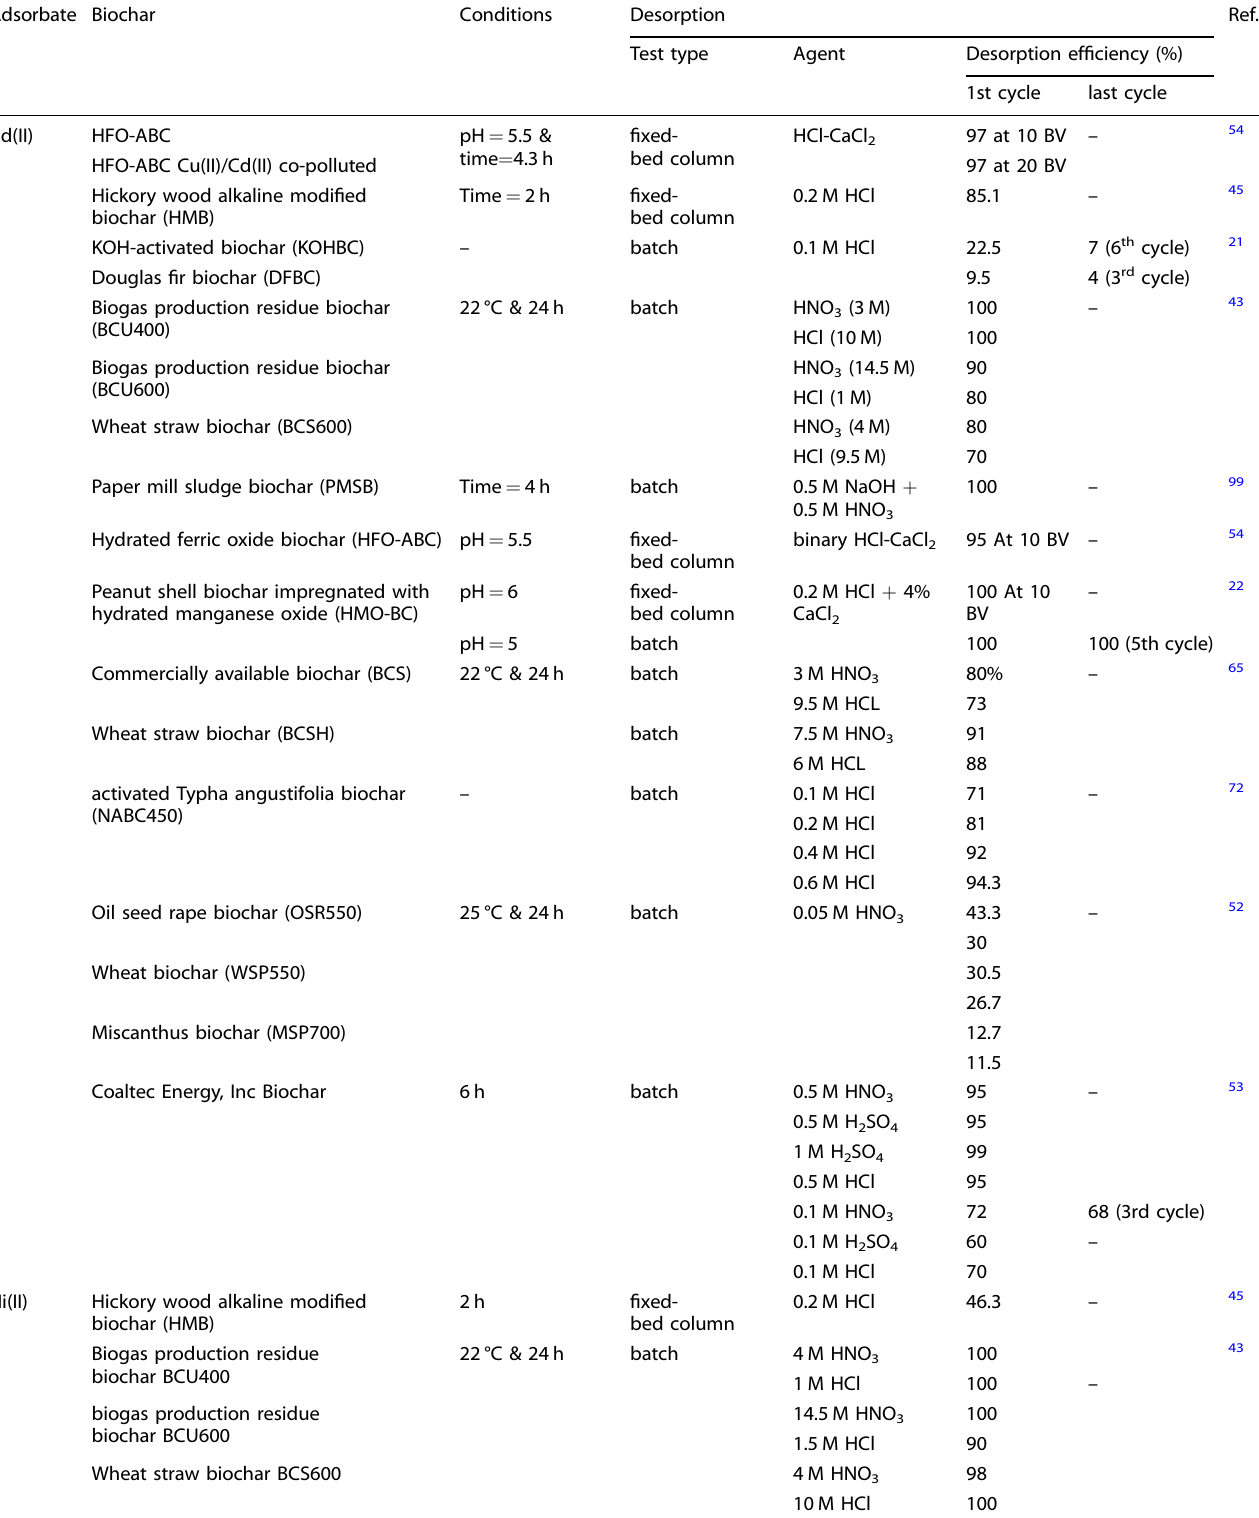
Table 8. Chemical desorption ef fi ciencies of biochar after adsorbing Cd(II) and Ni(II) from wastewater. Adsorbate